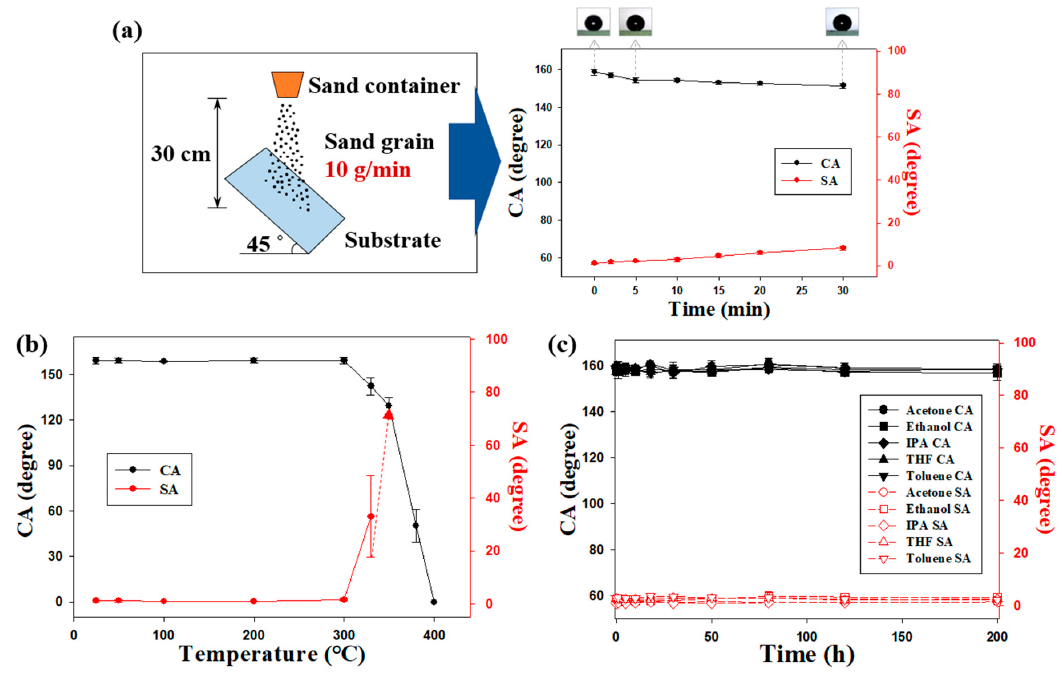
Figure 4. ( a ) Schematic of the sand abrasion test used to evaluate the robustness of coatings. The results of abrasion tests are shown in the right panel. ( b ) Thermal stabilities of superhydrophobic surfaces. ( c ) CAs and SAs of spray-coated surfaces after solvent resistance tests with acetone, ethanol, IPA, THF, and toluene.